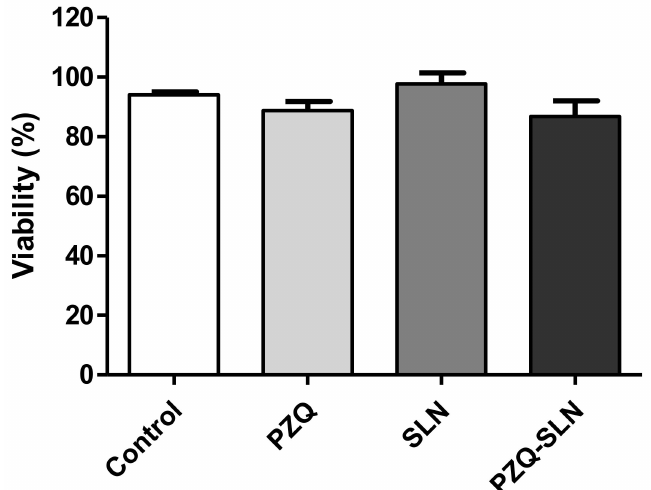
Figure 4. E ff ect of praziquantel, SLNs, and PZQ-SLNs supercritical in the evaluation of the viability of human L929 fibroblasts determined by the MTT assay after 24 h of incubation. The negative control (C) was treated with the vehicle used to dilute the drug (DMSO 5%). The data correspond to the mean ± SEM of four independent